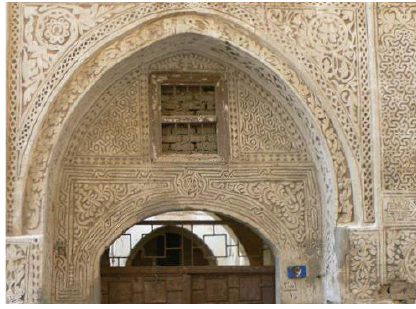
Figure 5: Decorated doorways (Source: SCTA, 2013).